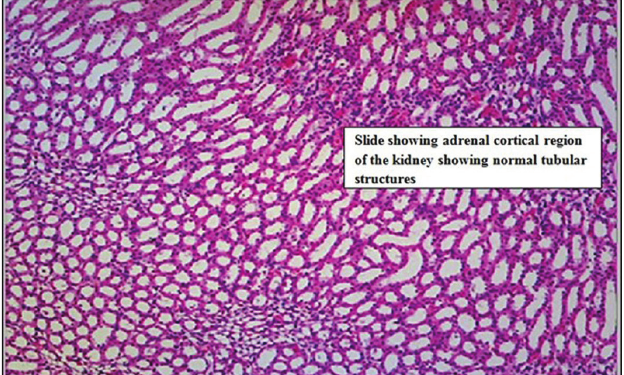
FIGURE 9 - Effect of risperidone on the kidneys of rats (2.5 mg/kg/d) (H & E, 100x,5 µ): Representative image of kidney of rats treated with risperidone (2.5 mg/kg/d) orally for three weeks showing thin walled endothelium of Bowman’s capsule, glomeruli with intact cellular borders, blood perfusion and convoluted tubules.